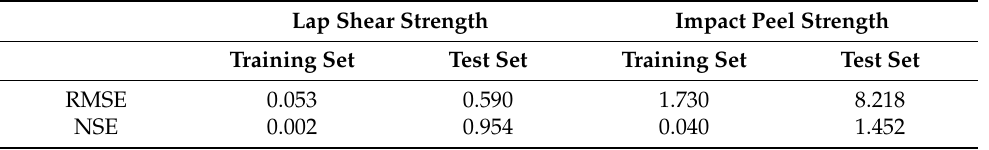
Table 2. The root mean squared error (RMSE) and normalized squared error (NSE) of the training set and test set for predicting the lap shear strength and impact peel strength using the ANN